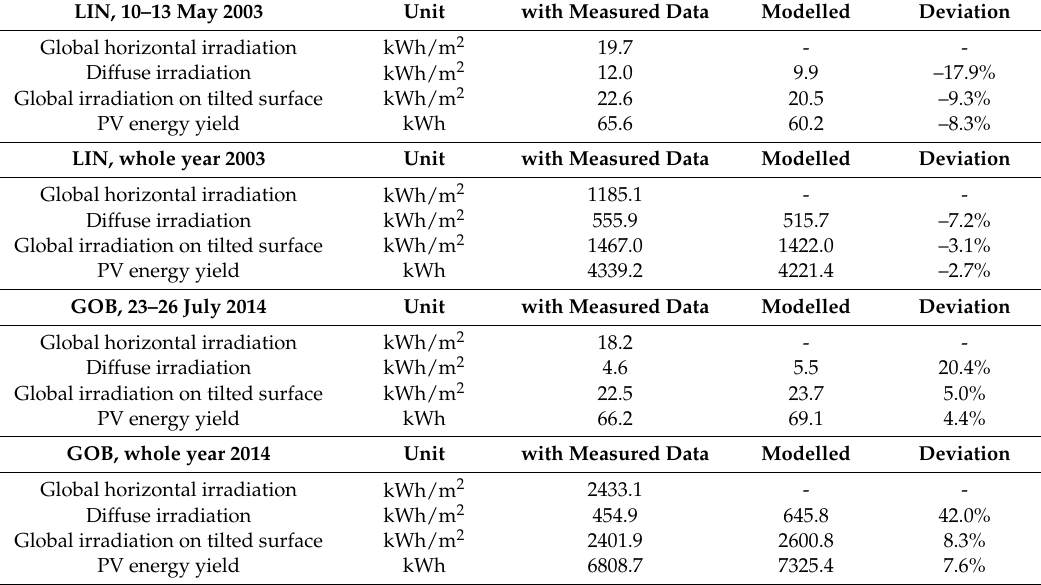
Table 1. Measured and modelled diffuse irradiation for Lindenberg, Germany (LIN), and Gobabeb, Namibia (GOB). The top section refers to the figures above, time ranges from 10–13 May 2003. The modelled underestimation of the diffuse irradiation by − 17.9% leads to an underestimation of the global irradiation on the tilted PV module by − 9.3%, hence leading to an underestimation of the simulated PV energy yield by 8.3%. When considering the whole year (2nd section), the modelled diffuse irradiation differs from the measured value by − 7.2%, leading to an underestimation of the irradiation on module surface by − 3.1%. The difference in the annual PV energy yield is − 2.7%. In the 3rd and 4th section, the results of the same analysis are presented for Gobabeb, Namibia. Here, the PV module faces North and is tilted at 23 ◦ . The modelled sum of diffuse irradiation for selected days (23–26 July 2014) is 20.4% higher than the measured sum, leading to a deviation in the PV energy of 4.4%. Over the whole year of 2014, the deviation of the diffuse irradiation is even 42%, which causes a difference in the annual PV yield of